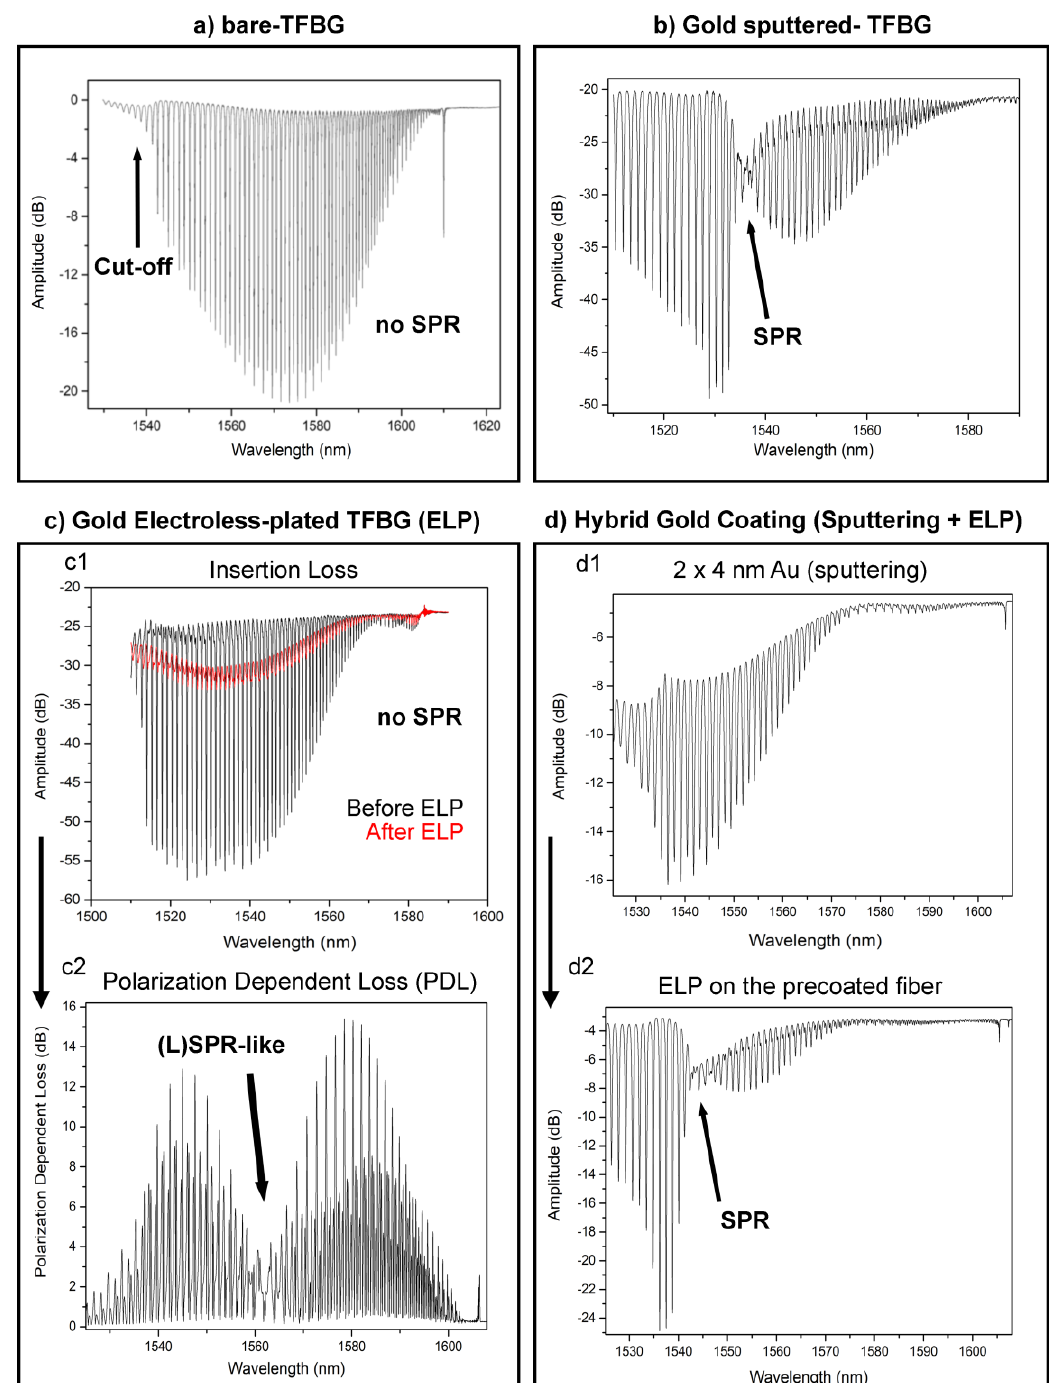
Figure 3. ( a ) Bare-TFBG amplitude spectrum monitored in PBS with the sensing part located at the cut-off area. ( b ) P-polarized spectrum of a sputter-coated TFBG with the most sensitive modes located at lower neighbor wavelengths of the SPR attenuation. ( c1 ) Transmitted amplitude spectrum before and after ELP process. ( c2 ) The same plating leads to a pronounced change in the PDL spectrum. ( d1 ) The deposition of a ~4 nm-thick gold layer by sputtering does not lead to SPR attenuation. ( d2 ) While the ELP is performed on that layer, the reaction can be stopped at the optimum point to reach SPR excitation using classical insertion loss interrogation.